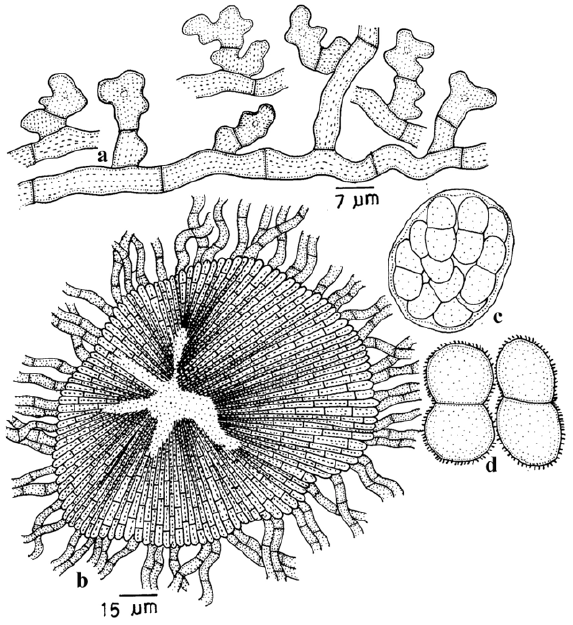
Figure 162. Asterina pongalaparensis a - Appressorium; b - Thyriothecium; c - Ascus; d -